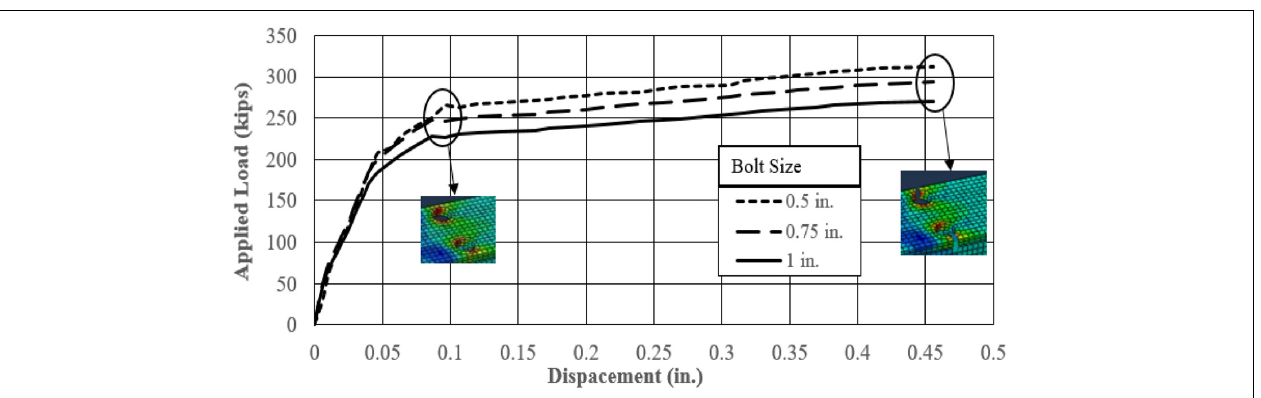
FIGURE 4 | FEA results for the W12 × 22 section with different bolt size. TABLE 1 | FEA results for the W16 × 45 and W12 × 22 sections with different bolts sizes. Section Bolt Dia.